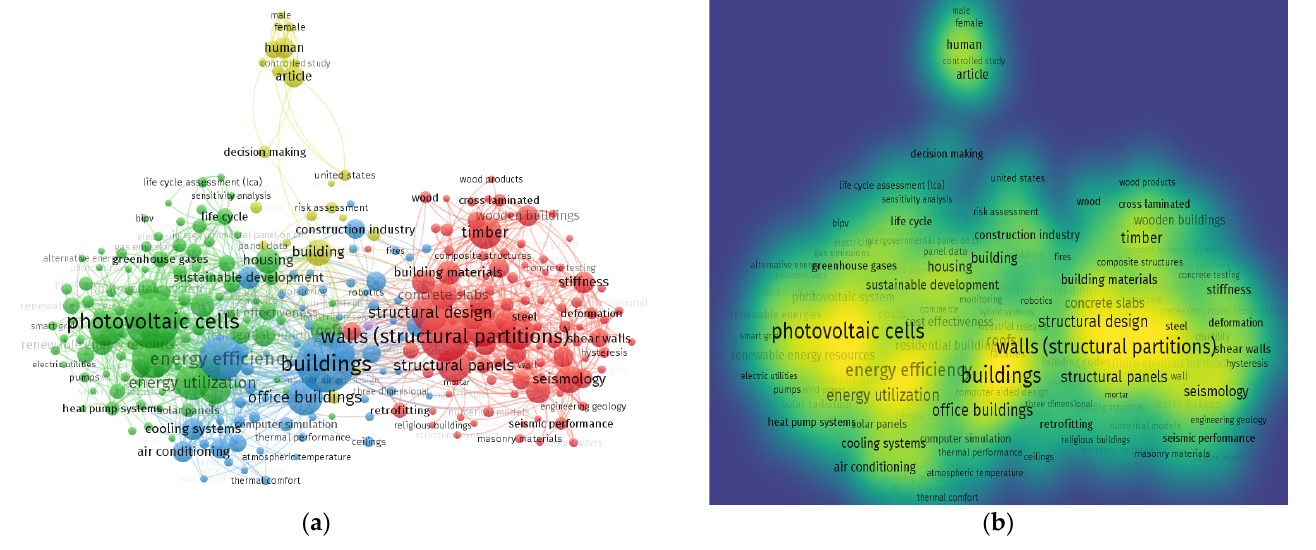
Figure 5. Results of scientometric analysis: ( a ) keywords network visualisation ( b ) keywords density visualisation .